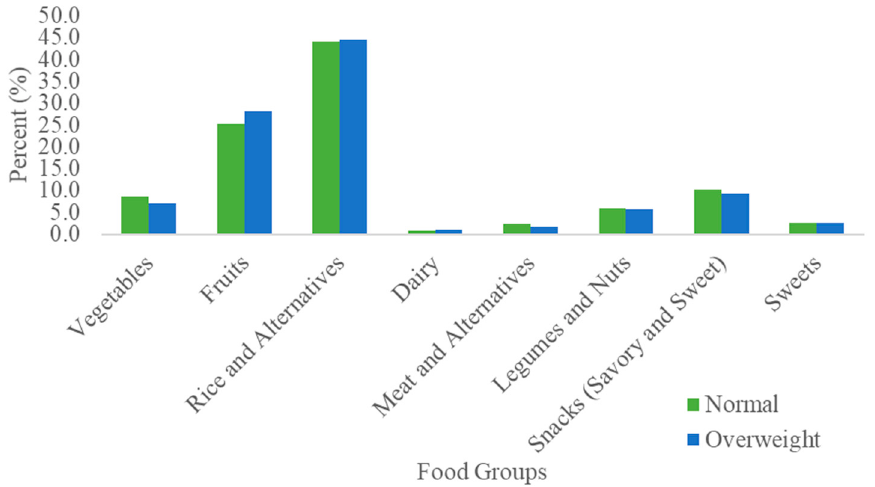
Figure 3. Percentage contribution of food groups to overall dietary fiber intake, by BMI group